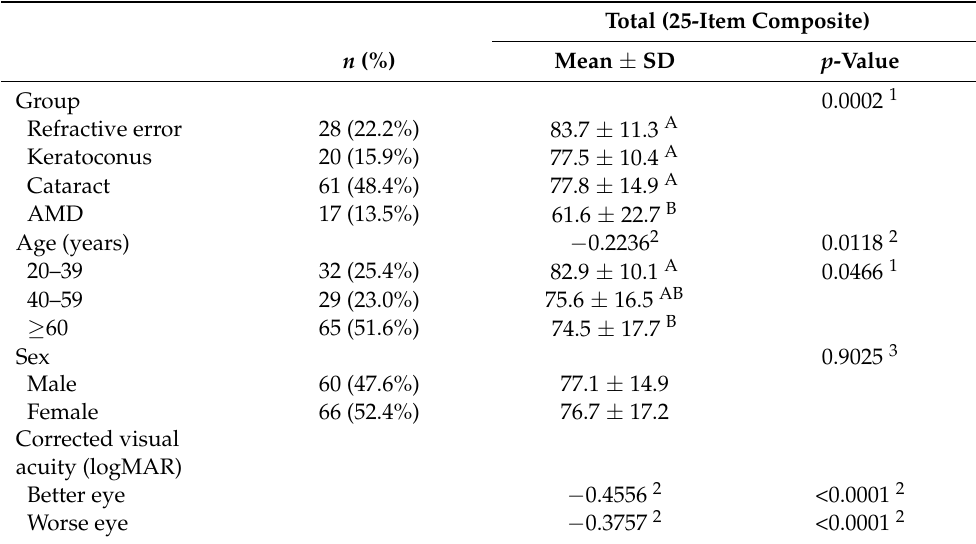
Table 3. Univariate analysis of the total score of NEI-VFQ-25 ( n = 126).